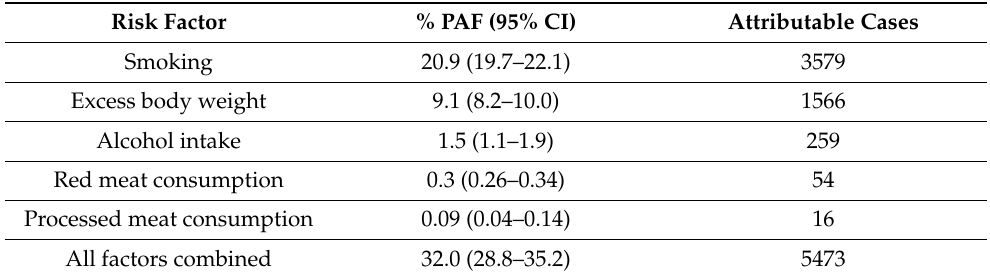
Table 6. The proportion and number of incident cancer cases (out of all cancer) in adults aged 30 years and older in Israel attributable to each evaluated risk factor, by risk